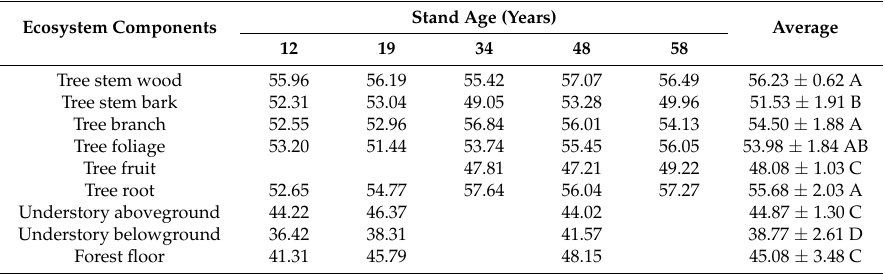
Table 4. Carbon concentration (%) of different ecosystem components in the 12-, 19-, 34-, 48-, and 58-year-old Mongolian pine ( Pinus sylvestris L. var. mongolica Litv.) stands. Stand Age Ecosystem Components